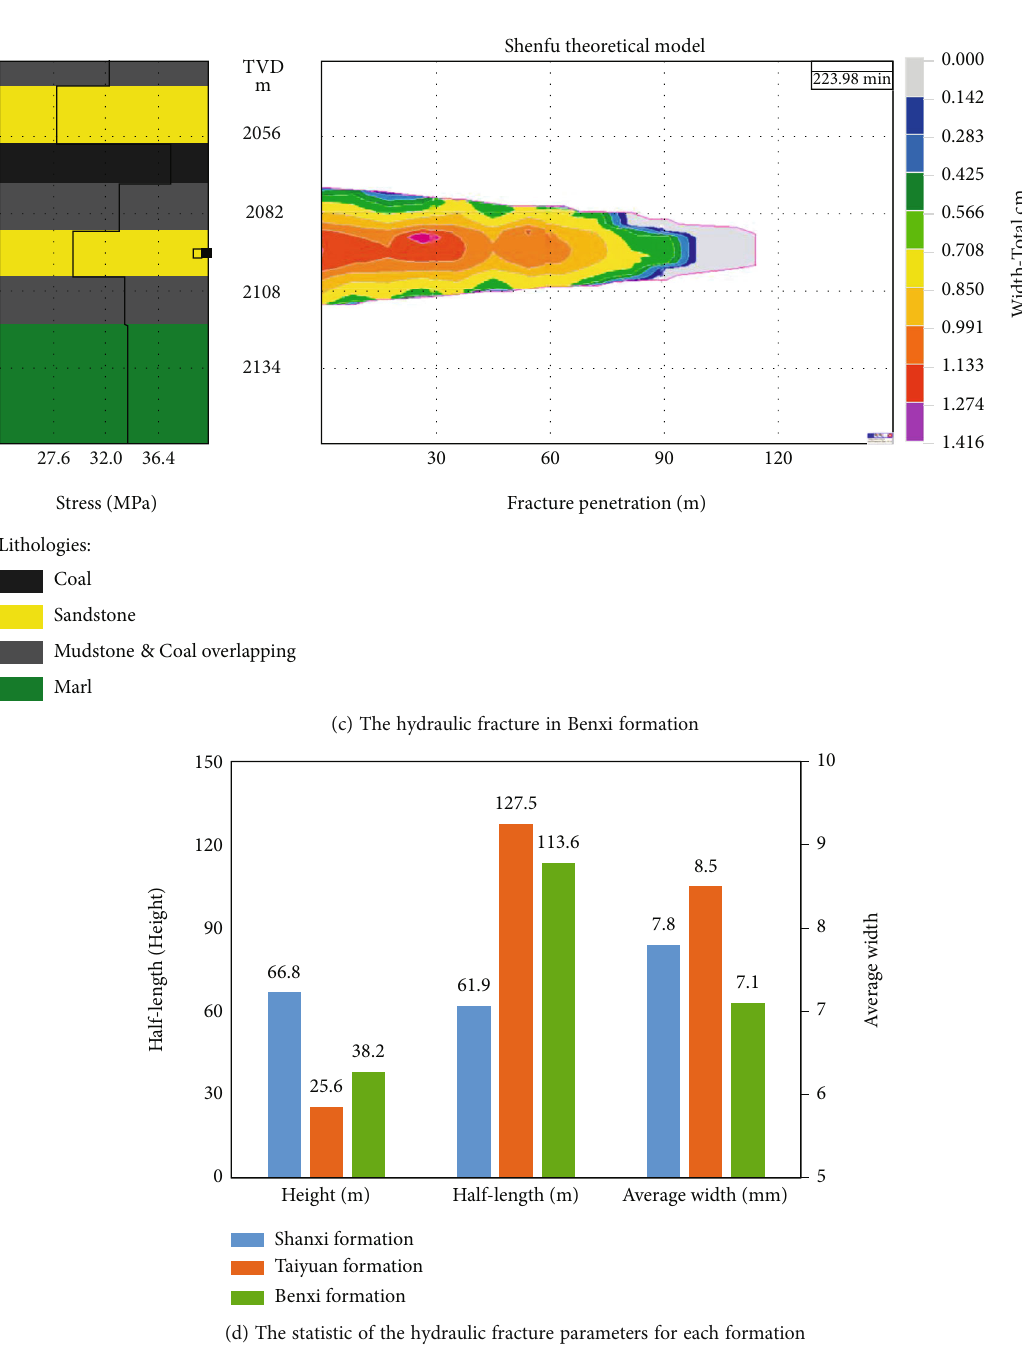
Figure 5: The numerical hydraulic fracture models after